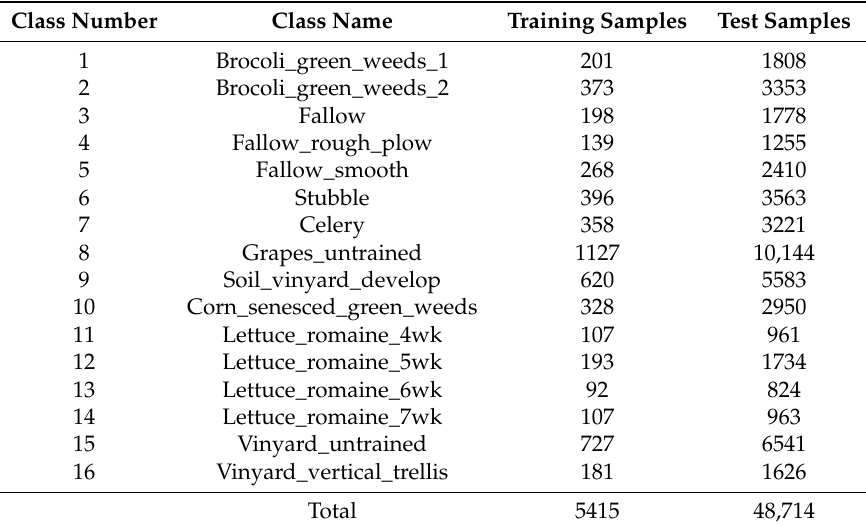
Table 3. Salinas dataset: Number of training and test